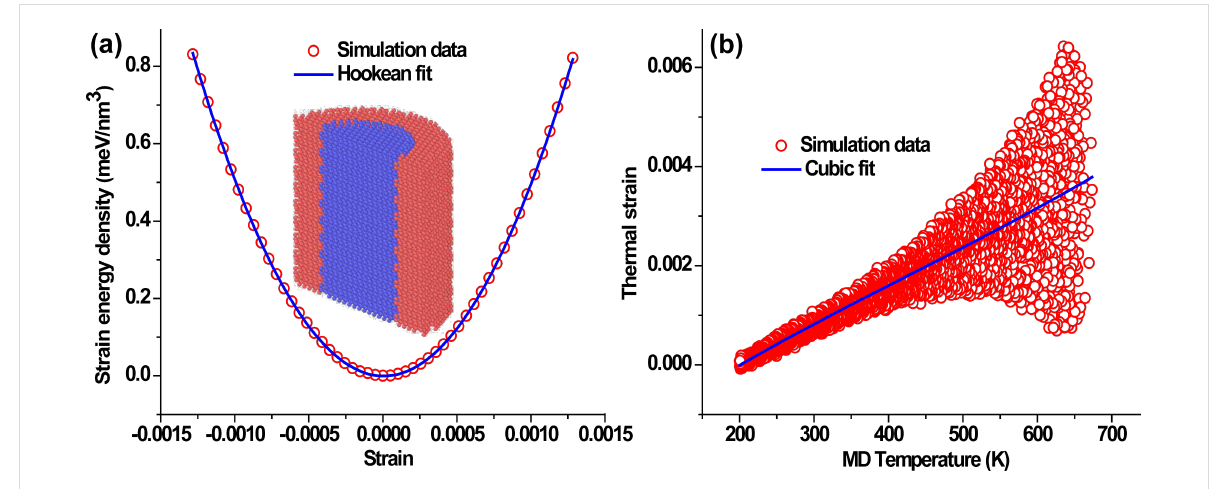
Figure 1: Methods for computing Young’s modulus and the thermal expansion coefficient: (a) Young’s modulus is computed by obtaining the strain energy as a function of longitudinal strain. The cross-sectional view of a typical CSNW is also shown. (b) The thermal expansion is obtained from the thermal strain in a direct MD simulation. At higher temperatures, the thermal fluctuations increase, thereby causing the MD data to be dispersed more broadly. The plots presented here correspond to a Si/Ge, <111> CSNW with a 4 nm core diameter.